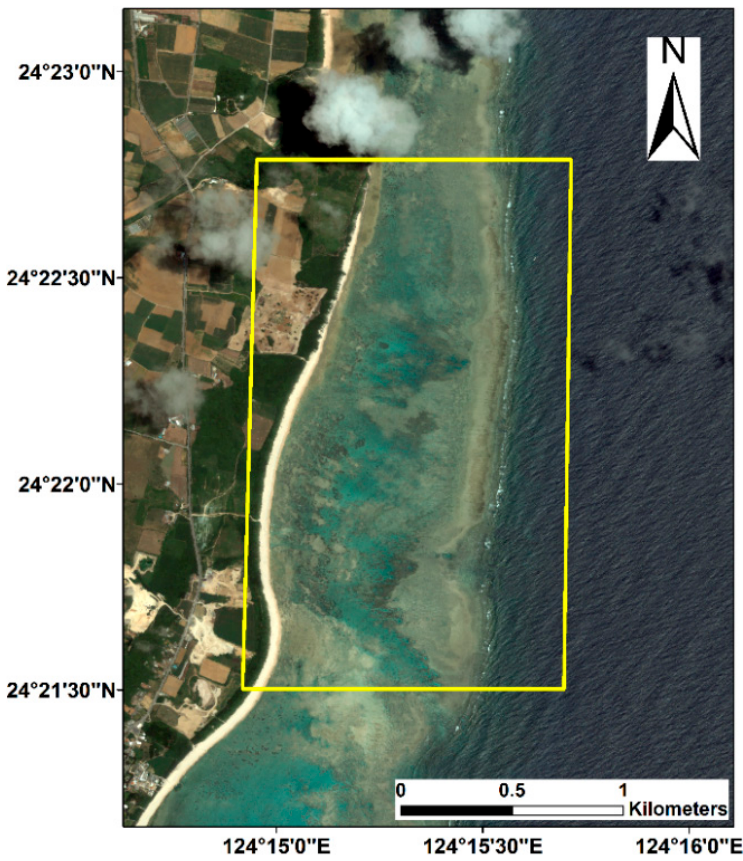
Figure 1. The study area of Shiraho, Ishigaki Island, Japan.